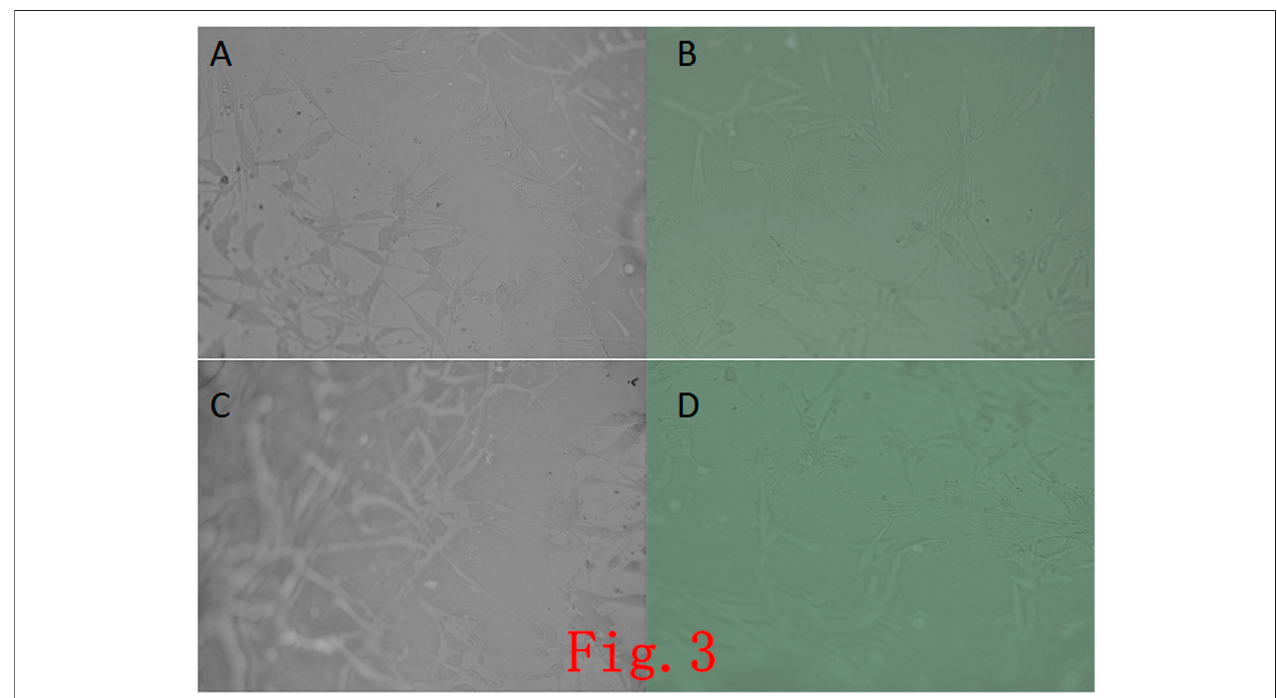
FIGURE 3 | Observation of cells in a self-assembled the nanopeptide hydrogel model combined with Ad-MSCs. (A) , (B) , (C) , (D) : Images of cells in the hydrogel photographed at different angles, showing that the cells in the hydrogel have a good growth condition with good adherence ( ×